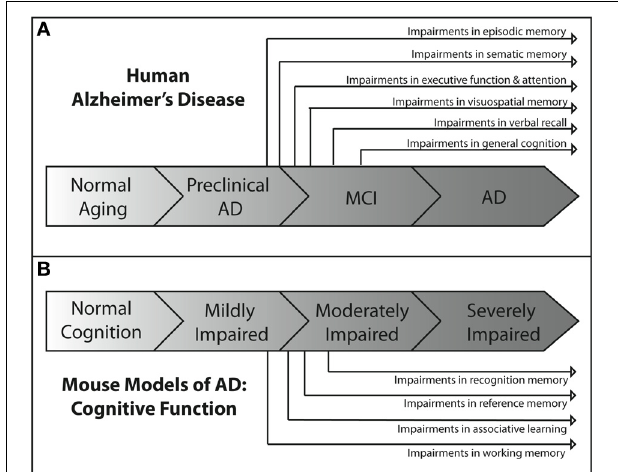
FIGURE 1 | Overview of the progression of cognitive deficits in human AD and in mouse models of AD. (A) In the human disease, the earliest AD-related cognitive deficits present themselves as episodic memory impairment during the late preclinical phase of the disease (Backman et al., 2005; Twamley et al., 2006; Bondi et al., 2008). Semantic memory deficits are the next to develop (Tuokko et al., 2005; Storandt et al., 2006), followed by impairments in executive functioning (Bondi et al., 2008), attention (Bondi et al., 2008), and visuospatial memory (Twamley et al., 2006) near the beginning of the MCI phase of the disease. As MCI progresses, deficits in verbal recall (Kryscio et al., 2006; Bondi et al., 2008) develop and impairments in general cognition (Bondi et al., 2008) become apparent. As the patient transitions into AD, all cognitive domains become affected. (B) The development of cognitive deficits in APP mouse models of AD shows similar patterns of progression. Consistently, the earliest observable impairments are in spatial working memory (Webster et al., 2013), as assessed through the use of water maze based tasks. These impairments are generally followed temporally by impairments in associative learning and reference memory, as assessed by maze alternation (Lalonde et al., 2012) and fear conditioning tasks (Kobayashi and Chen, 2005). Deficits in recognition memory usually present later in the spectrum of cognitive impairment than deficits in other domains (Eriksen and Janus, 2007; Hall and Roberson, 2012; Webster et al.,